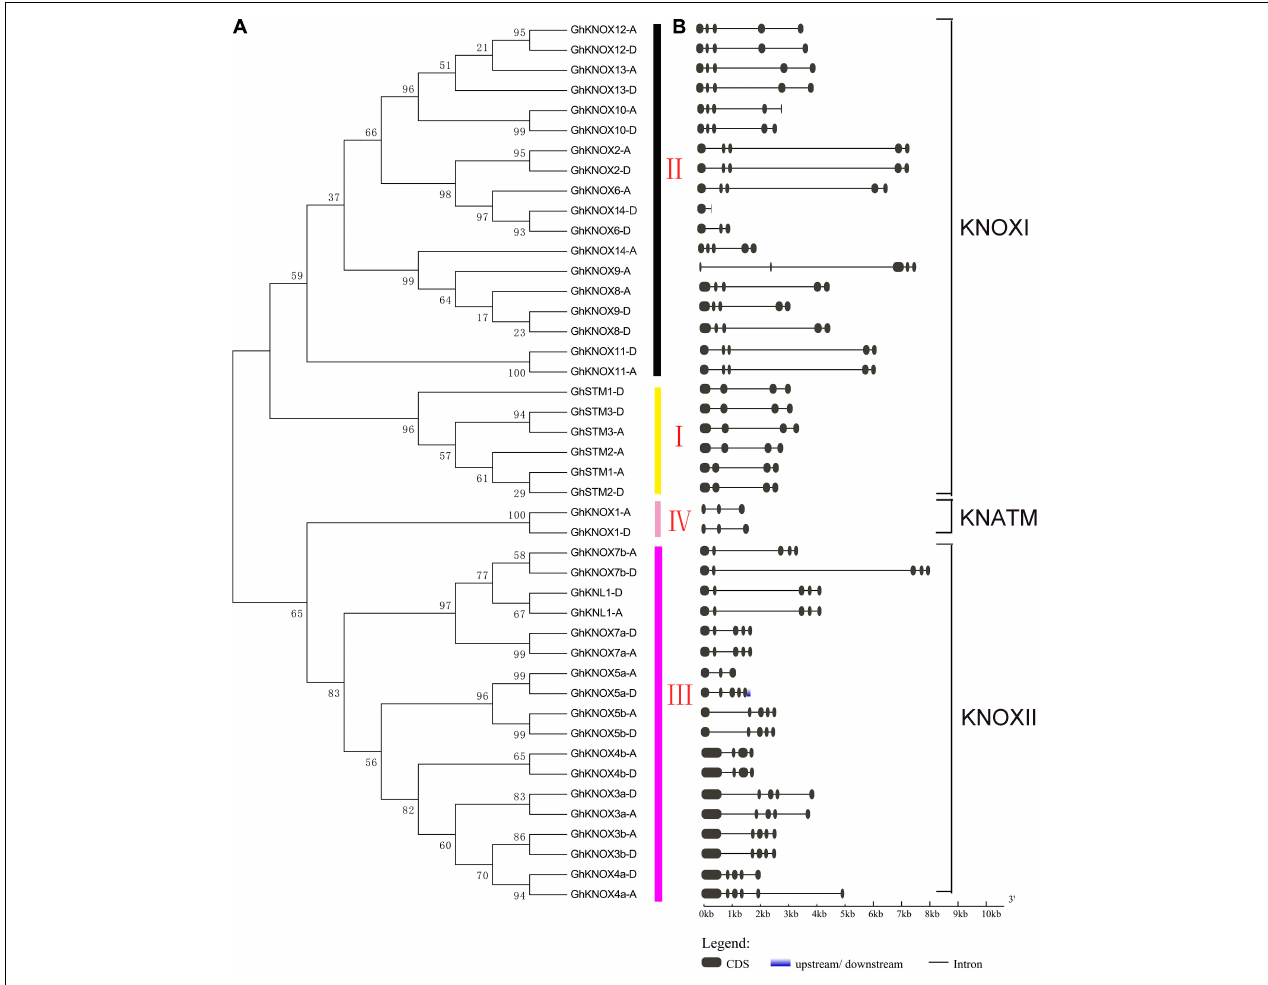
FIGURE 2 | Phylogenetic relationships and genomic structure of GhKNOX genes. (A) Neighbor-joining tree of GhKNOX s. The GhKNOX genes were classified into four subclades (I, II, III, and IV). The subclades I and II were clustered in the KNOXI clade. The subclades III and IV belonged to the KNOXII and KNATM clades, respectively. (B) Exon–intron structural features of GhKNOX genes. Black boxes and lines indicate exons and introns,